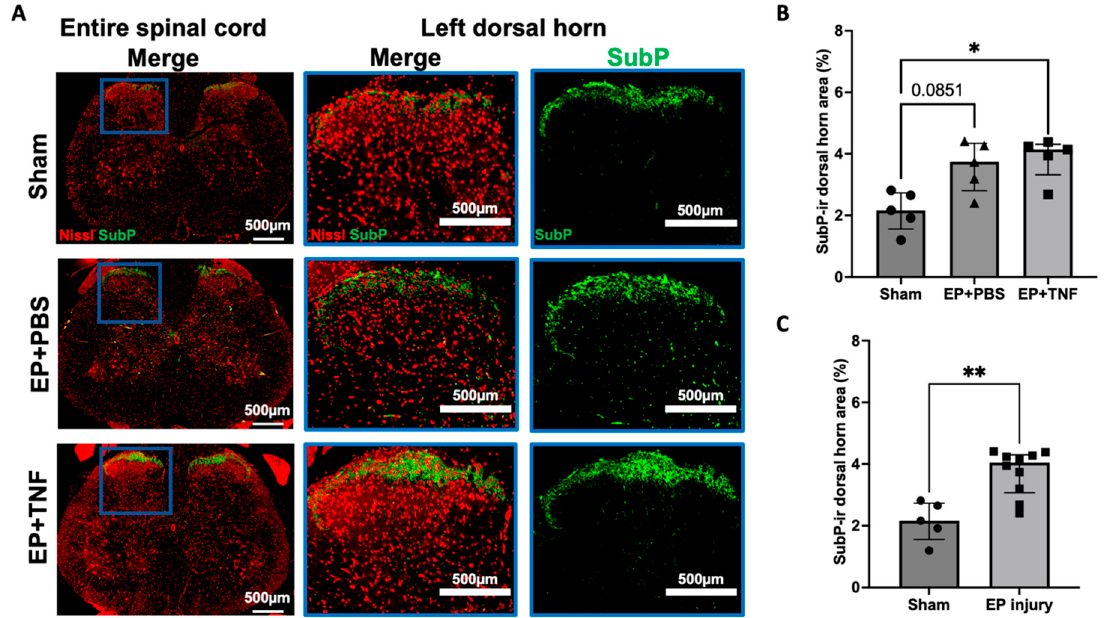
Figure 4. EP injury increased SubP in spinal dorsal horn with no effect of injectate. ( A ) Representative images of SubP immunohistochemical staining with Nissl stain in the entire spinal cord and left dorsal horn. ( B ) EP injury with PBS and TNF α injections increased SubP-ir in the spinal cord dorsal horn. ( C ) Combined EP injury increased SubP-ir in the spinal cord dorsal horn. * p < 0.05. ** p < 0.01. Iba1 and GFAP are markers for activated microglia and astrocytes, respectively, which are important glial cells in the spinal cord. Iba1 and GFAP-ir were evenly distributed in the spinal cord dorsal horn (Figures 5A and 6A). Compared to the sham group, the percentages of Iba1-ir and GFAP-ir were relatively higher in both EP + PBS and EP + TNF groups, but only GFAP-ir showed a significant difference between EP + TNF ( p < 0.05; Figure